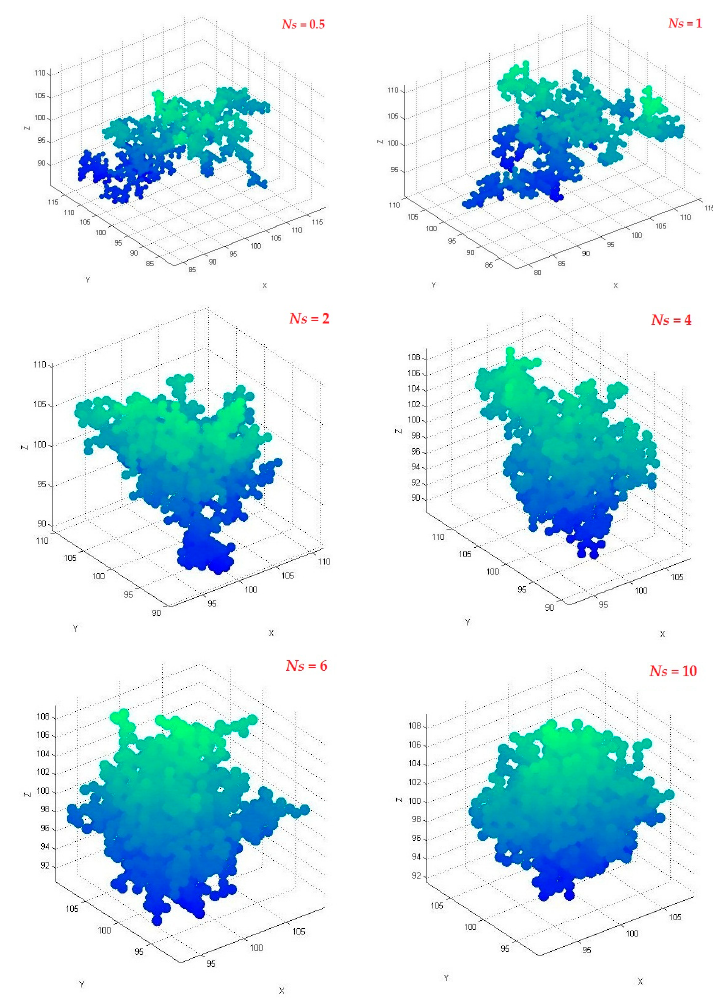
Figure 6. 3D DLA aggregates with different motion step lengths.